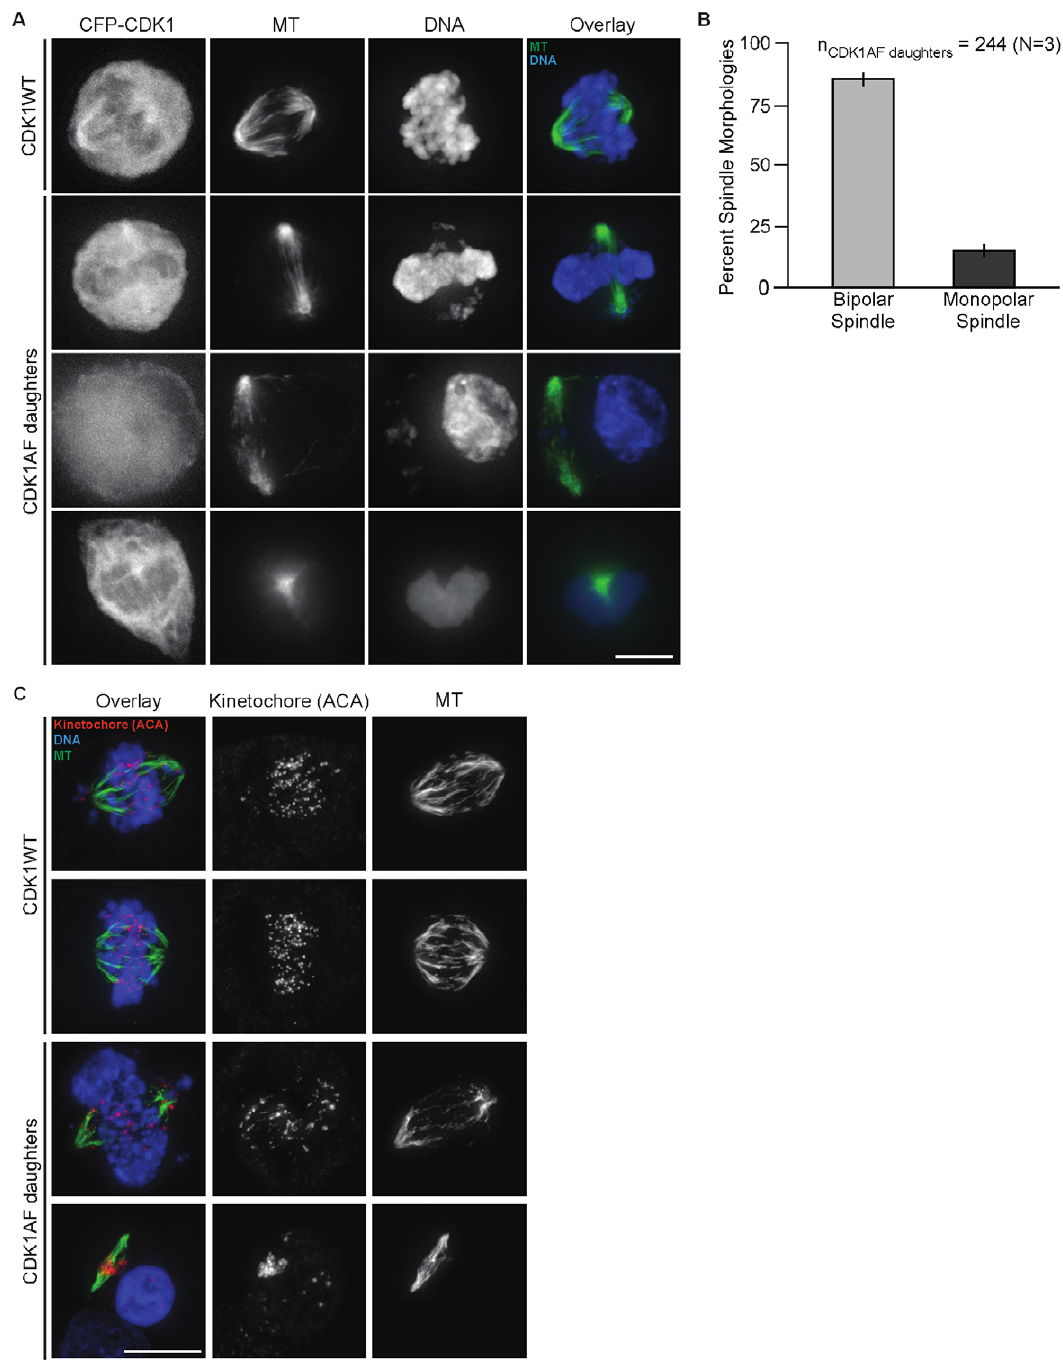
Figure 2. Bipolar spindle maintenance does not require completed DNA replication or condensation. (A) CDK1-CFP, microtubules (MT), DNA, and the overlay of MT and DNA in CDK1WT mitotic cells and daughters of CDK1AF expressers. Microtubules (green) and DNA (blue) are shown. (B) Histogram of spindle morphology observed in M-phase-like G1 cells (CDK1AF daughters), with percent bipolar (light gray) and monopolar spindles (dark gray). (C) Kinetochores (ACA; magenta), microtubules (MT), and the overlay of both of these plus DNA from cells in the same population described in (A). Scale bars=10 m M. doi:10.1371/journal.pone.0033835.g002 pHH3 was detected in CDK1WT-expressing cells treated with DMSO control (Figure 3D).